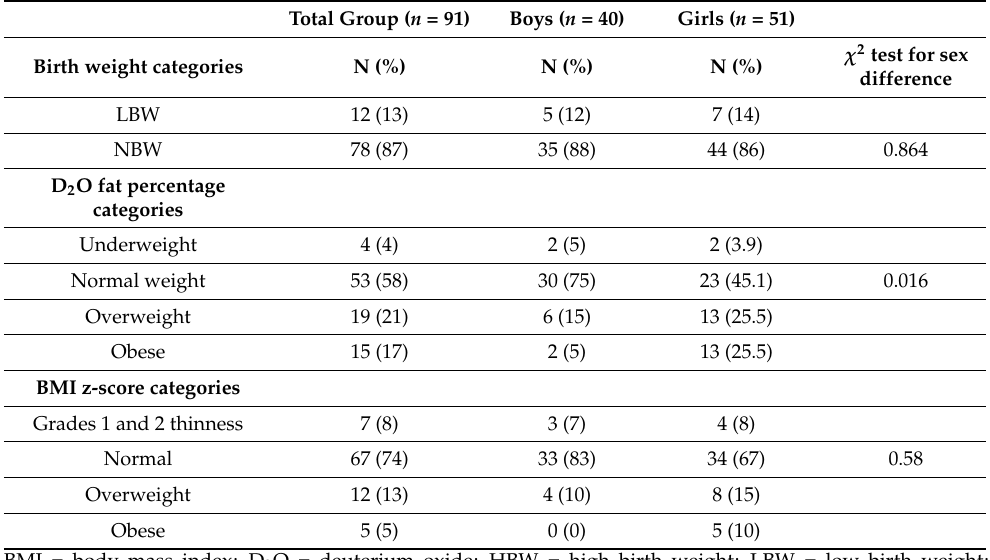
Table 2. Birth weight, D 2 O and BMI z-score percentage score for the total group and by